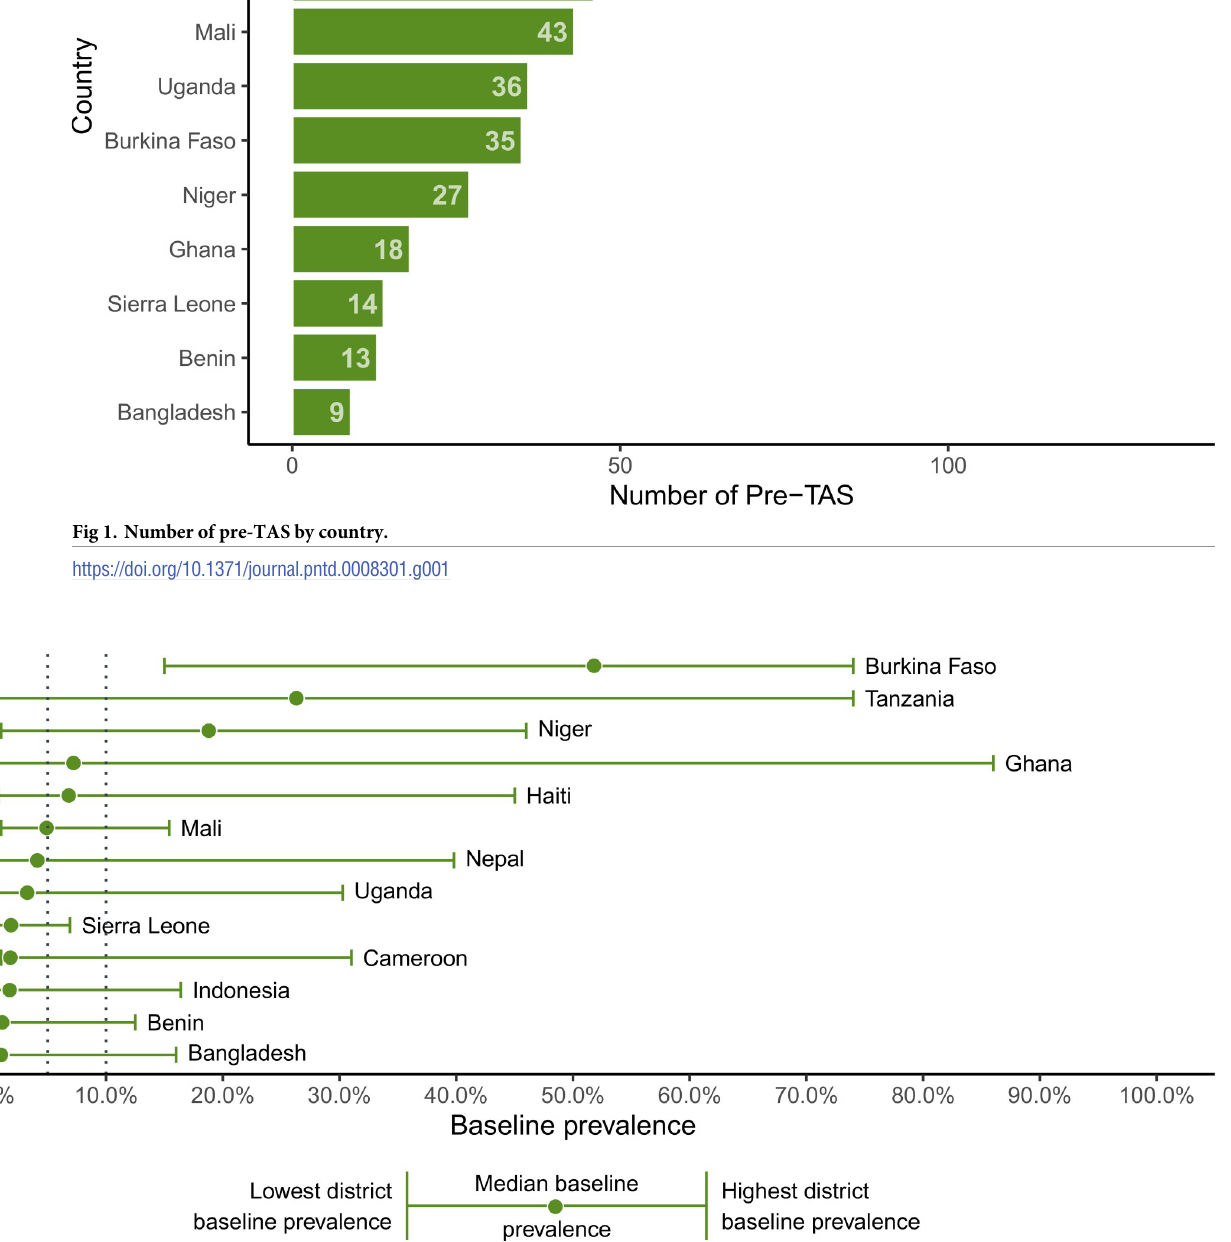
Fig 2. District-level baseline prevalence by country.